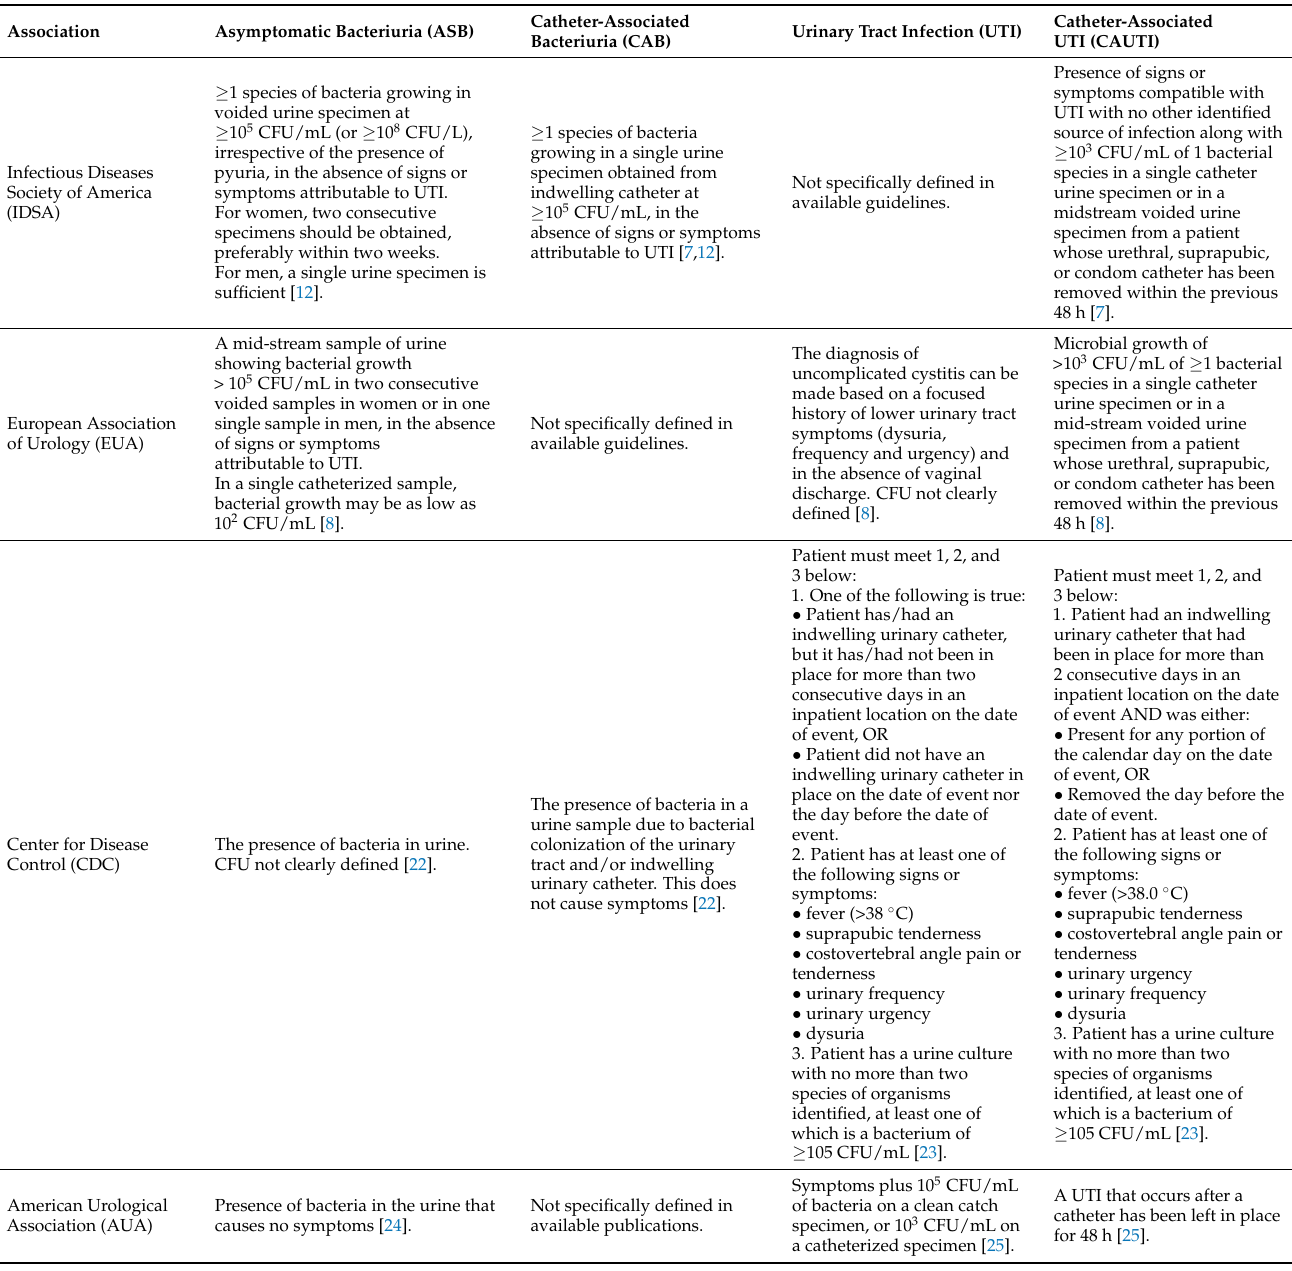
Table 1. Societal definitions of asymptomatic bacteriuria and urinary tract infections with and without